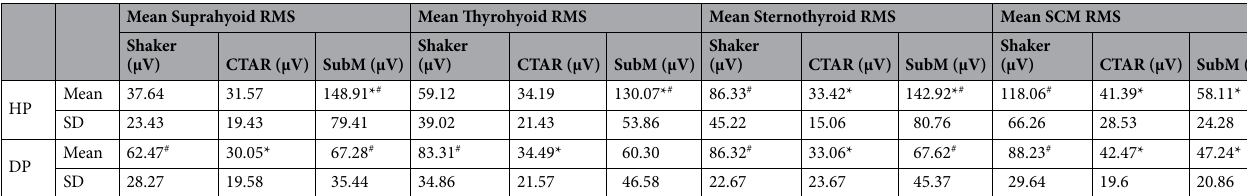
Table 3. The mean RMS value of the suprahyoid, thyrohyoid, sternohyoid, and SCM muscles in healthy participants and patients with dysphagia. RMS; root mean square, SD; standard deviation, CTAR; chin tuck against resistance, SubM; submandibular push exercise, SCM; sternocleidomastoid, Max; maximum, HP; healthy participants, DP; dysphagic patients. versus Shaker; * p < 0.05, versus CTAR; # p <